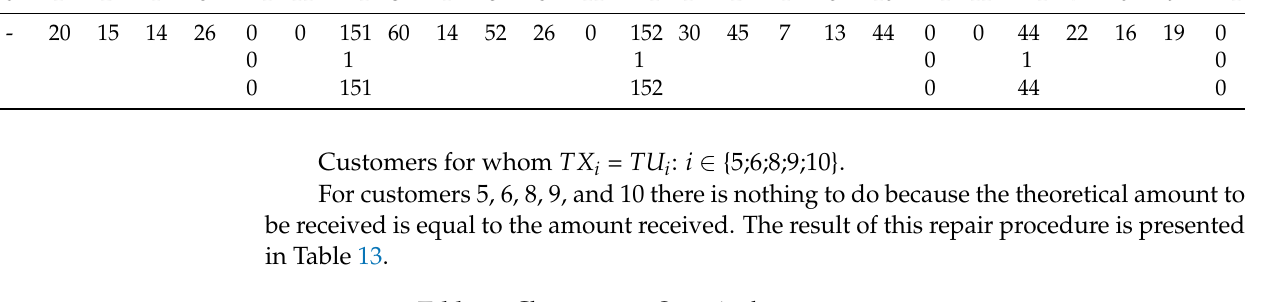
Table 13. Chromosome C